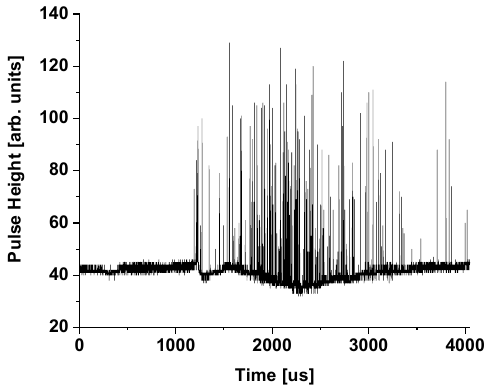
Fig. 2. Recorded waveform of single burst of the IBR-2. Full range is 20500 us